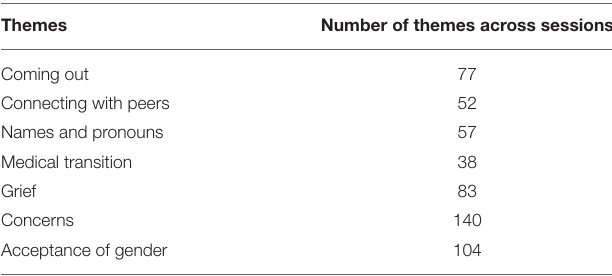
TABLE 1 | Themes across